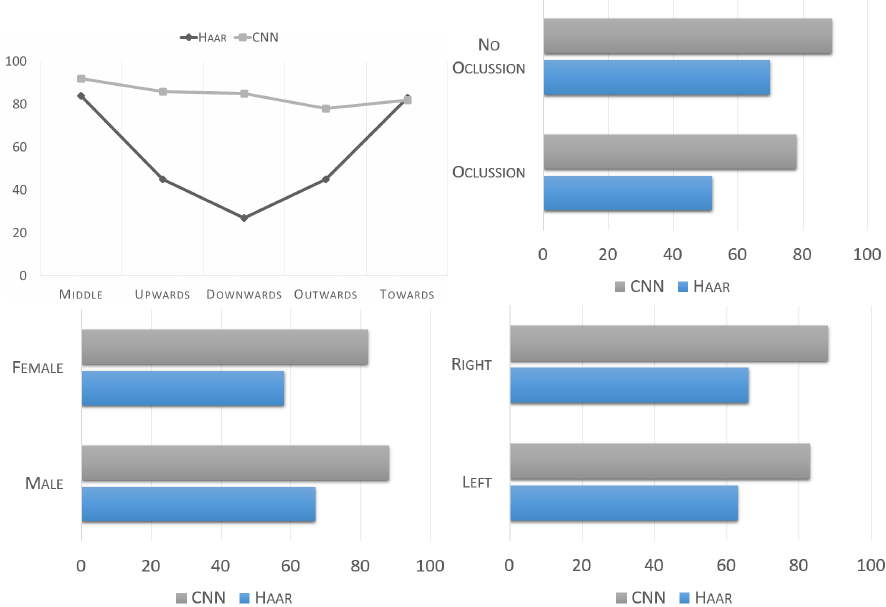
Figure 12. Detection performance of our 3-CNN system vs Haar on the different data folds of the UBEAR dataset: ( Top Left ) Angle Sensitivity, ( Top Right ) Occlusion Sensitivity, ( Bottom Left ) Gender Sensitivity, ( Bottom Right ) Ear Side